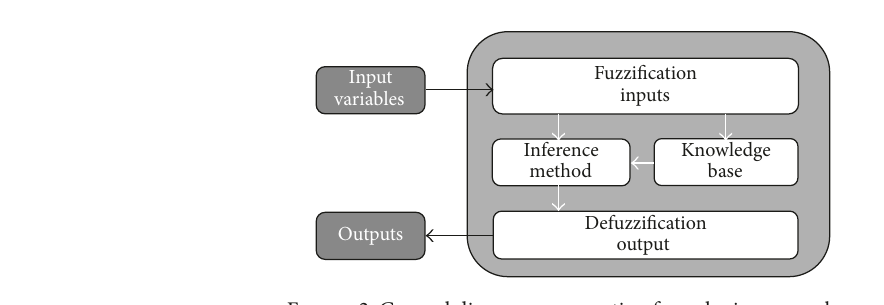
Figure 2: General diagram representing fuzzy logic